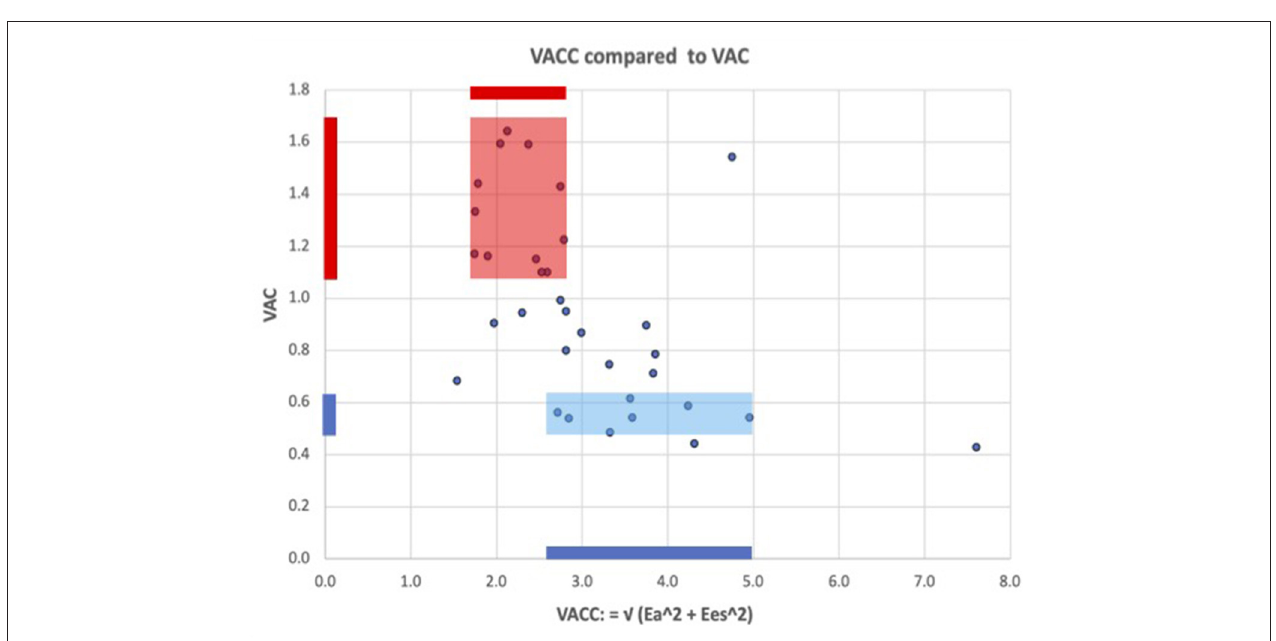
VAC 0.62 and VAC/LVEF 1. LVEF Left ventricle ejection fraction, VAC ventriculo-arterial coupling. = = =